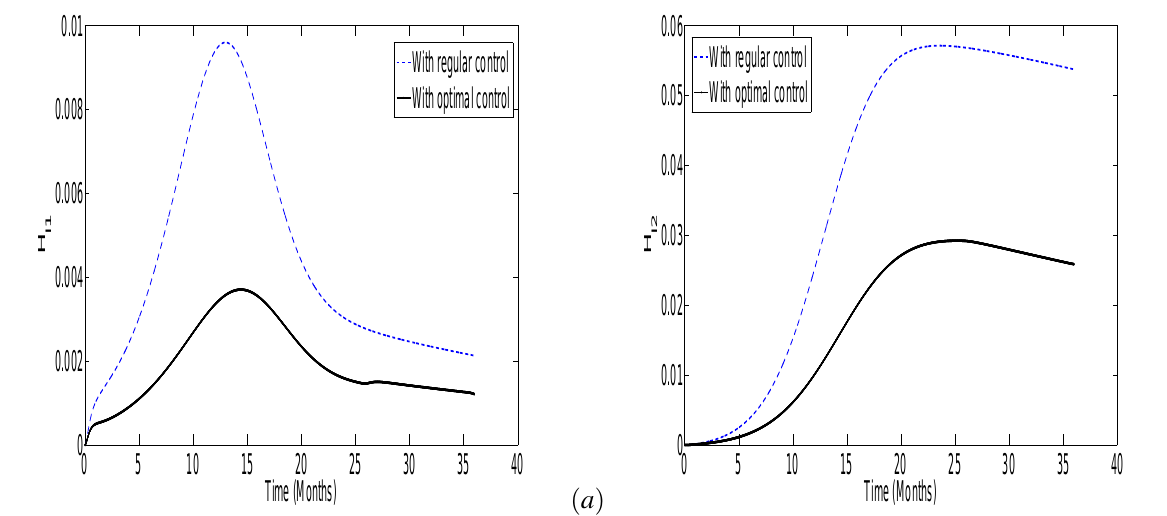
Fig. 3 Graphs of the numerical simulation of the optimality system, showing the propagation of ( a ) individuals dually infected with HIV and acute HSV-2, also under HSV-2 anti-viral treatment and ( b ) individuals dually infected with HIV and acute HSV-2, also not under HSV-2 anti-viral treatment, over a period of 36